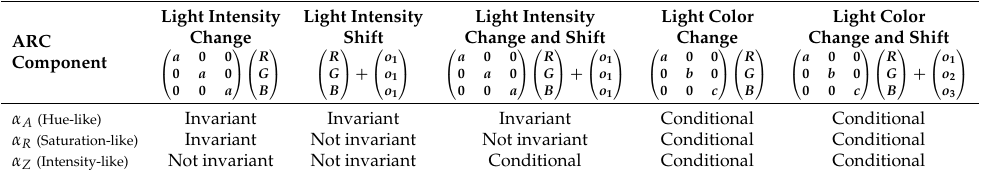
Table 2. Invariant properties of each ARC component α A , α R , α Z , with respect to various transforma- tions in light